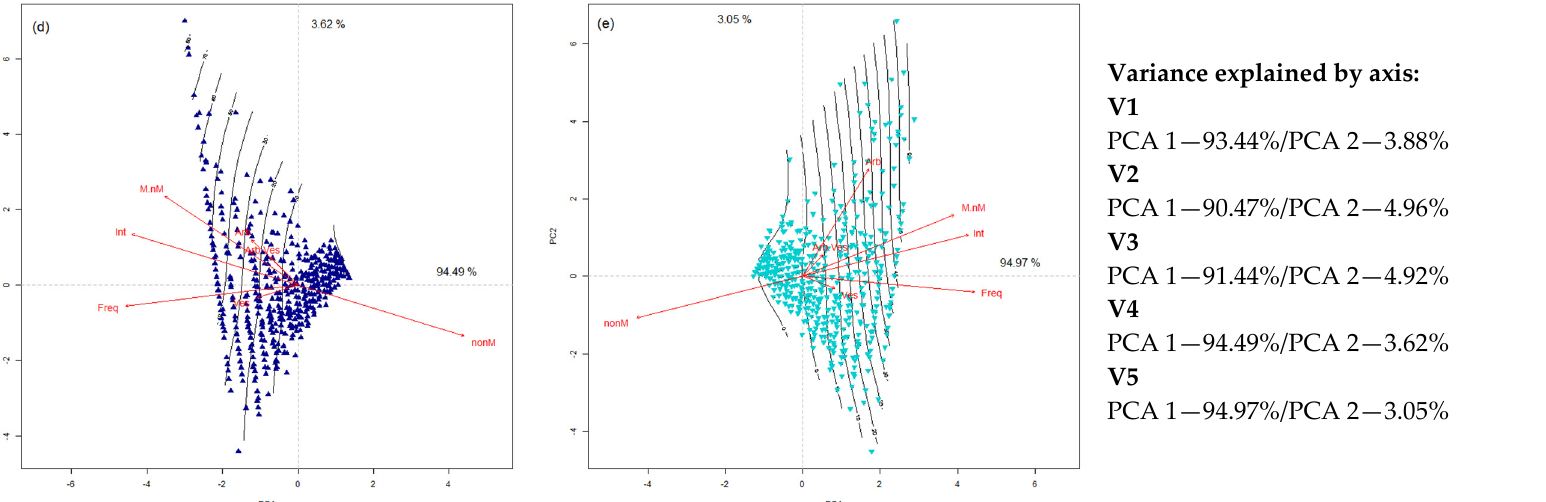
Figure 2. PCA ordinations of mycorrhizal patterns in roots of F. rubra as projected on colonization degree based on the influence of applied treatments. ( a ) V1